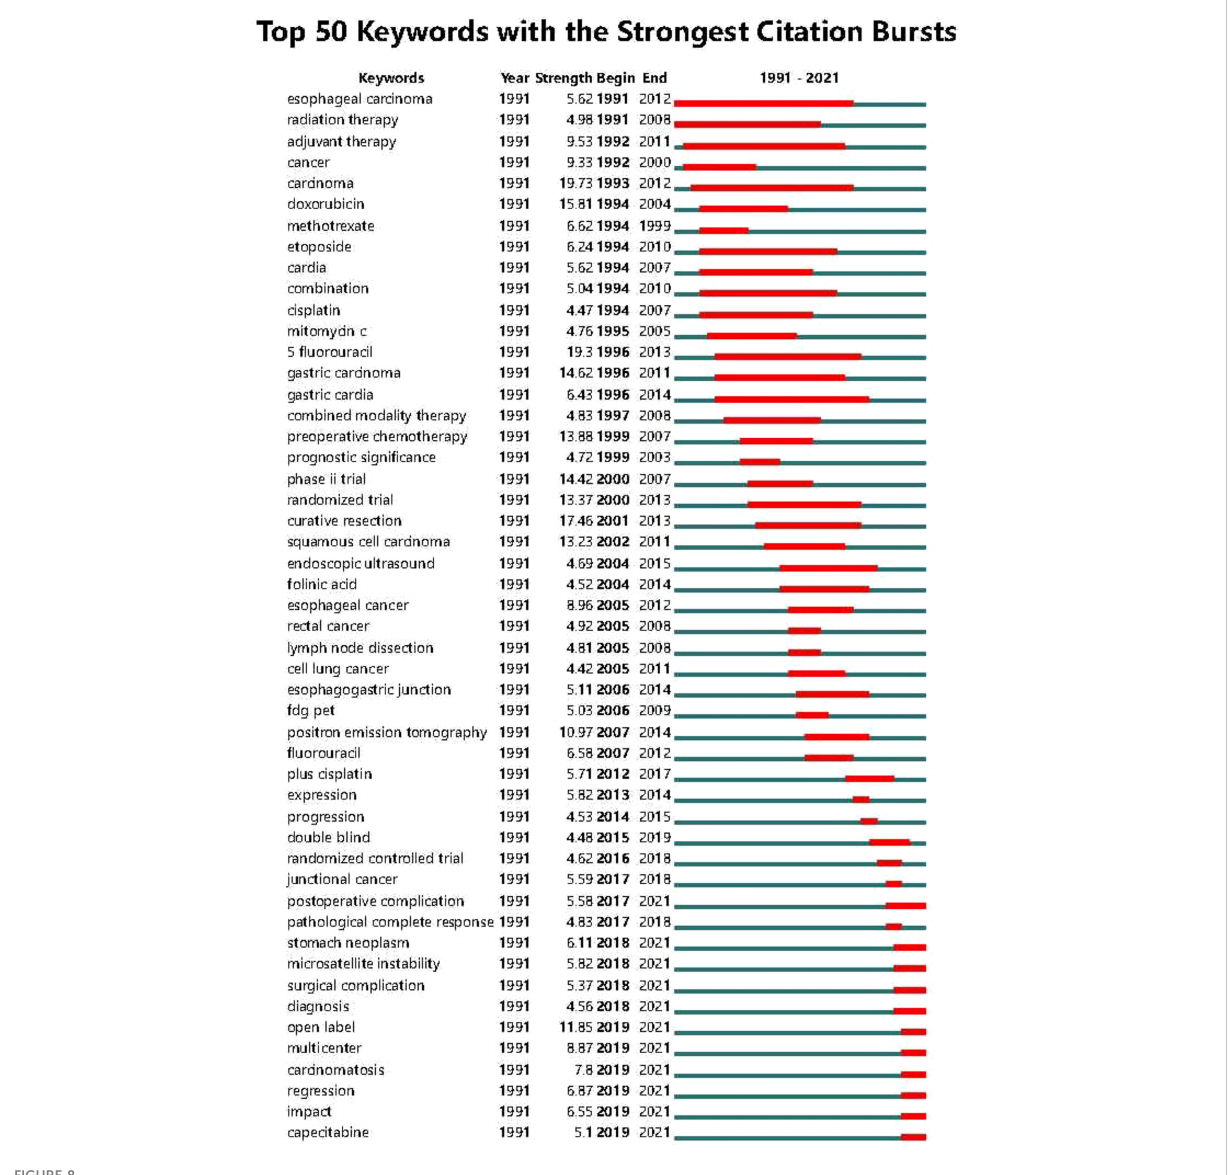
FIGURE 8 Top 50 keywords with strong citation bursts in the articles related to GC neoadjuvant chemotherapy from 1991 to